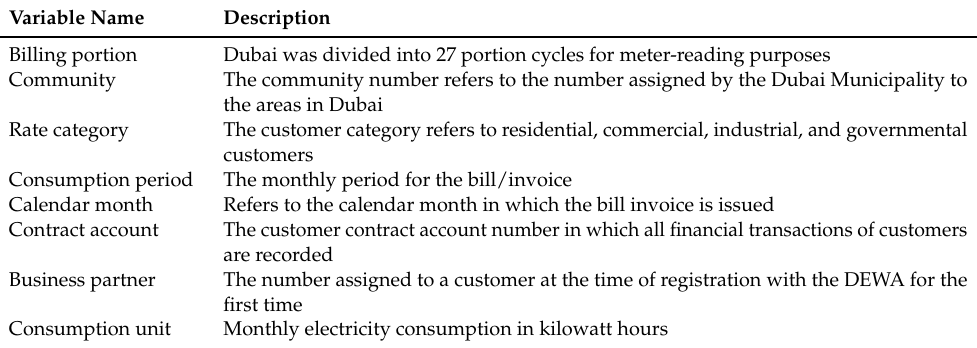
Table 2. Feature description of the DEWA